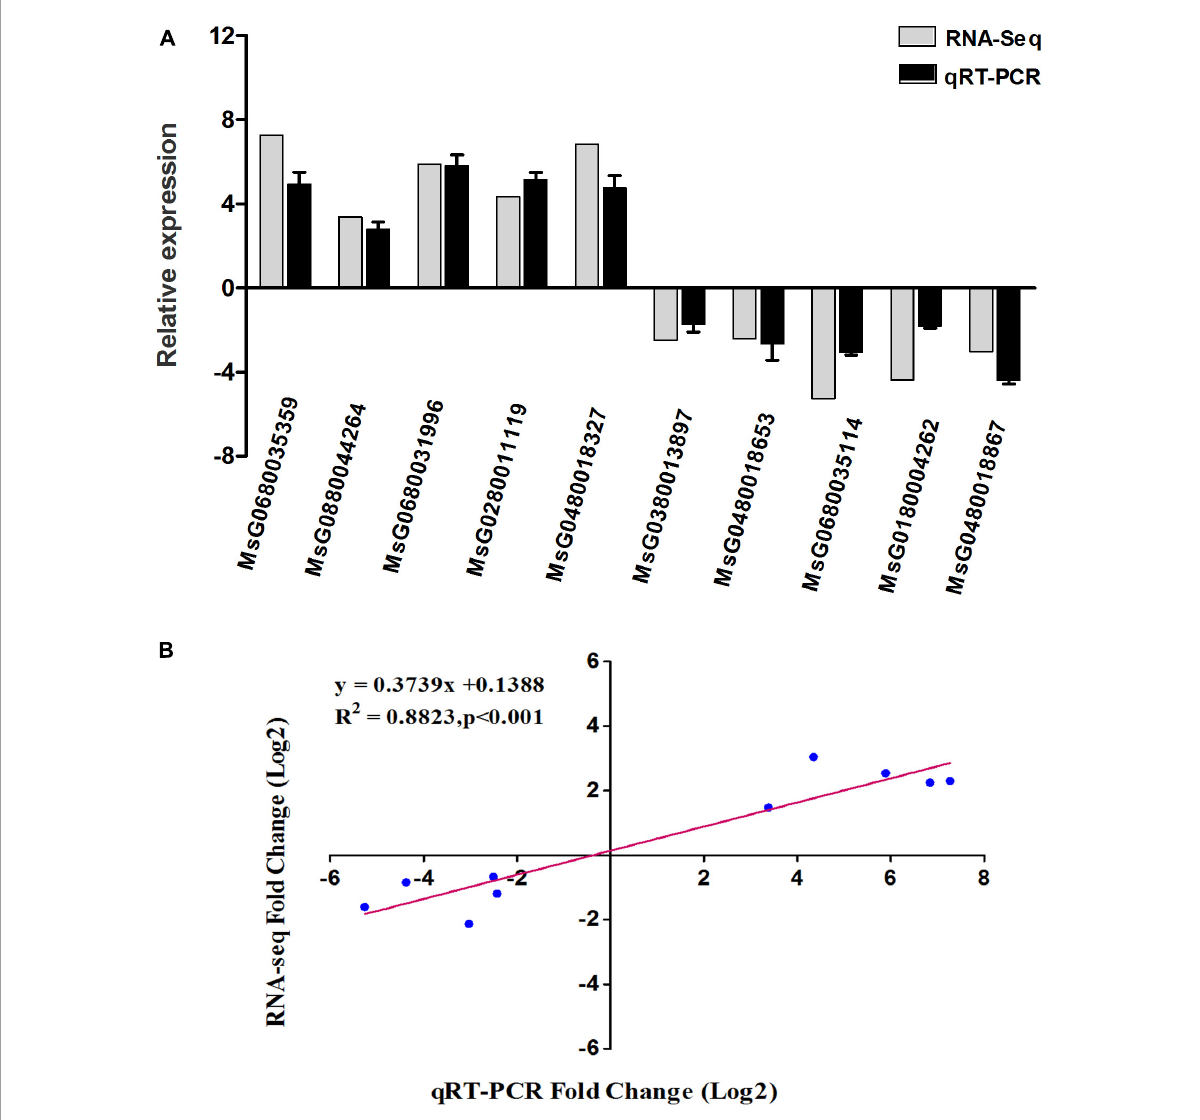
FIGURE8 The relative expression levels of 10 DEGs identified in the comparison between RNA-Seq and qRT-PCR. (A) The gene relative expression levels were normalized to the expression level of GAPDH . Error bars represented the standard deviations of three PCR replicates. (B) R -values are the correlation coefficients between qRT-PCR and